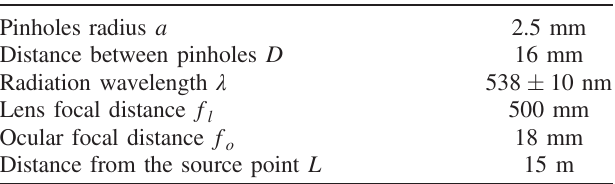
TABLE II. Characteristics of the ALBA SRI setup. Pinholes radius